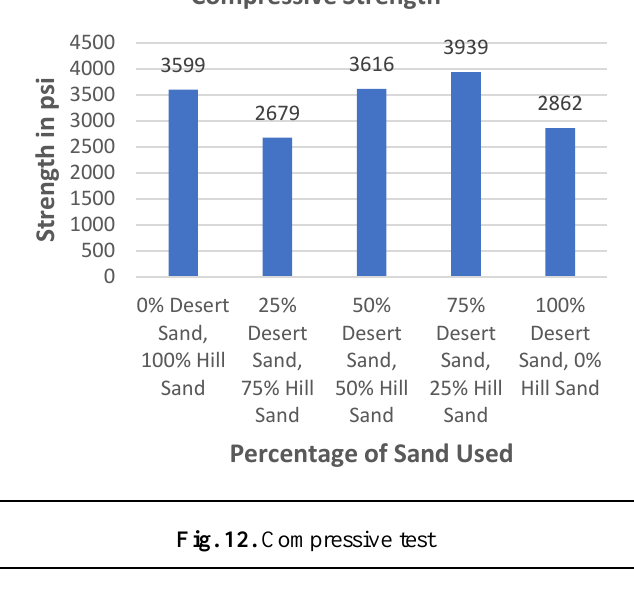
Fig. 12. Compressive test